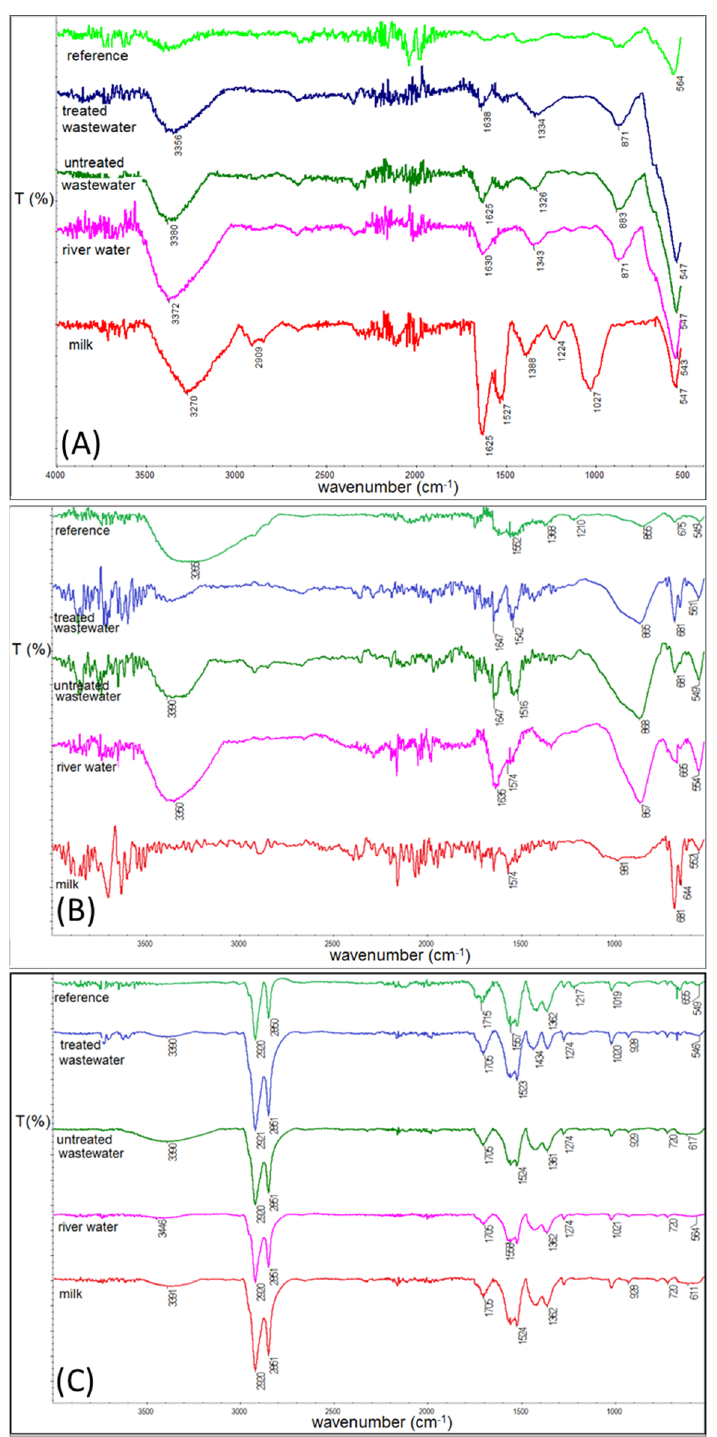
Figure 3. IR spectra of both kinds of tested nanoparticles in various environmental solutions. ( A ) Fe 3 O 4 ; ( B ) SiO 2 @Fe 3 O 4 nanoparticles; ( C ) Fe 3 O 4 @Fe 3 O 4 nanoparticles. IR spectra of Fe 3 O 4 nanoparticles (Figure 3A) after wetting in untreated wastewater, treated wastewater, and river water do not show any significant changes in comparison to the reference. Only bands identified as Fe-O bonds in goethite (870 cm − 1 ) [43] and maghemite (around 650 cm − 1 ) [44] become more intensive. On the contrary, the IR spectrum of the nanoparticles wetted in milk shows a strong additional signal (1030 cm − 1 ), which may be related to fat and proteins residues [45]. The comparison of the reference spectra